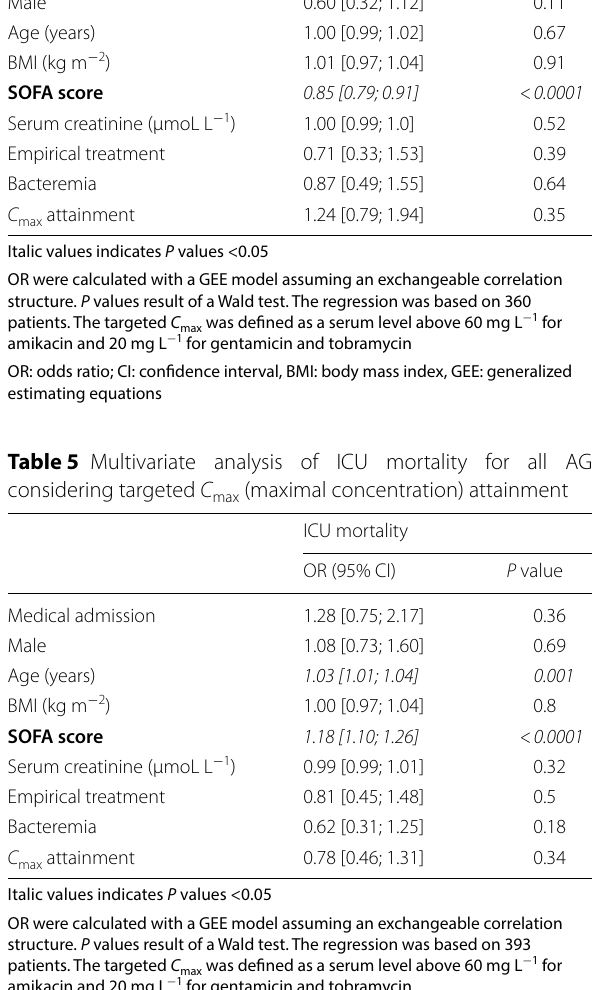
Table 4 Multivariate analysis of clinical success for all AG considering targeted C (maximal concentration) attainment max